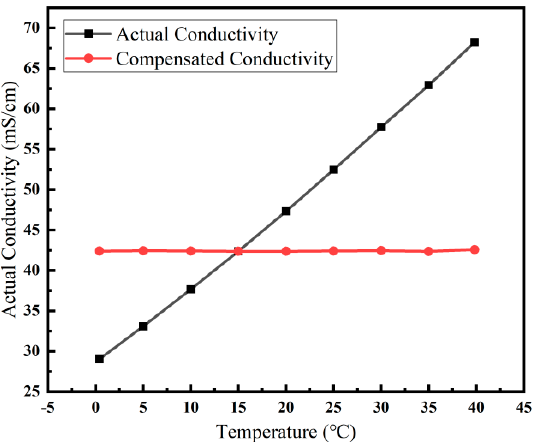
Figure 13. Measured values of the sensor at different temperatures compared to the temperature compensated